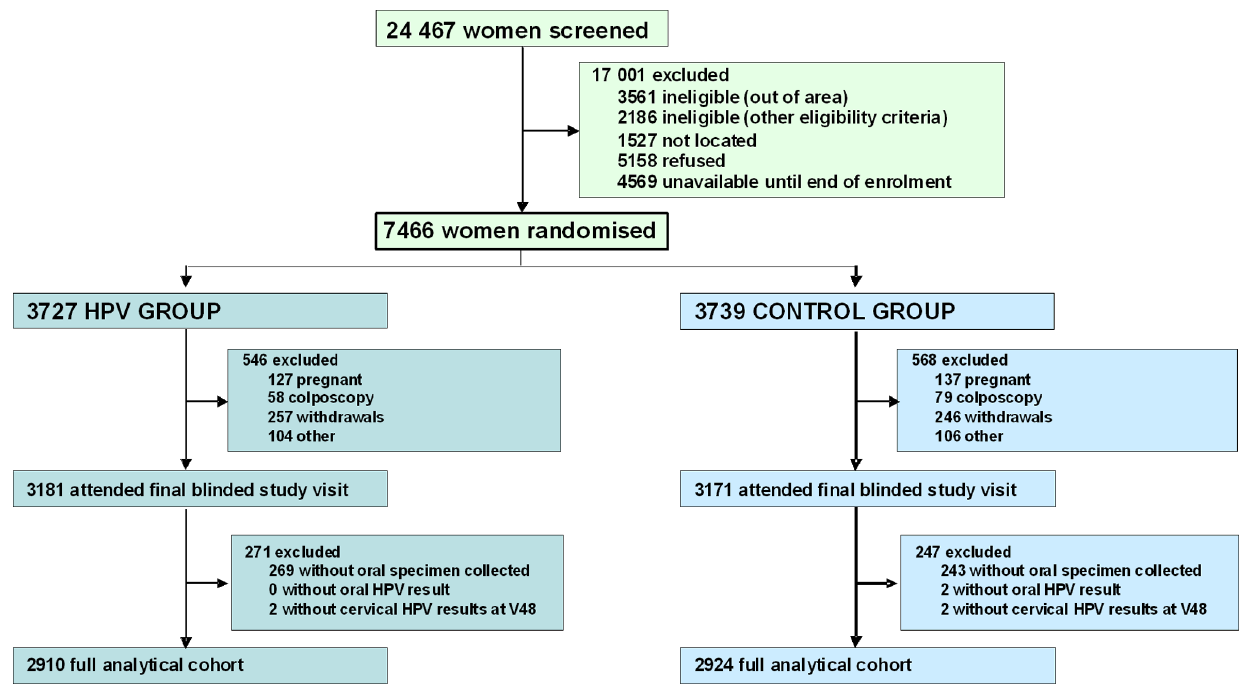
Figure 1. Consort diagram.